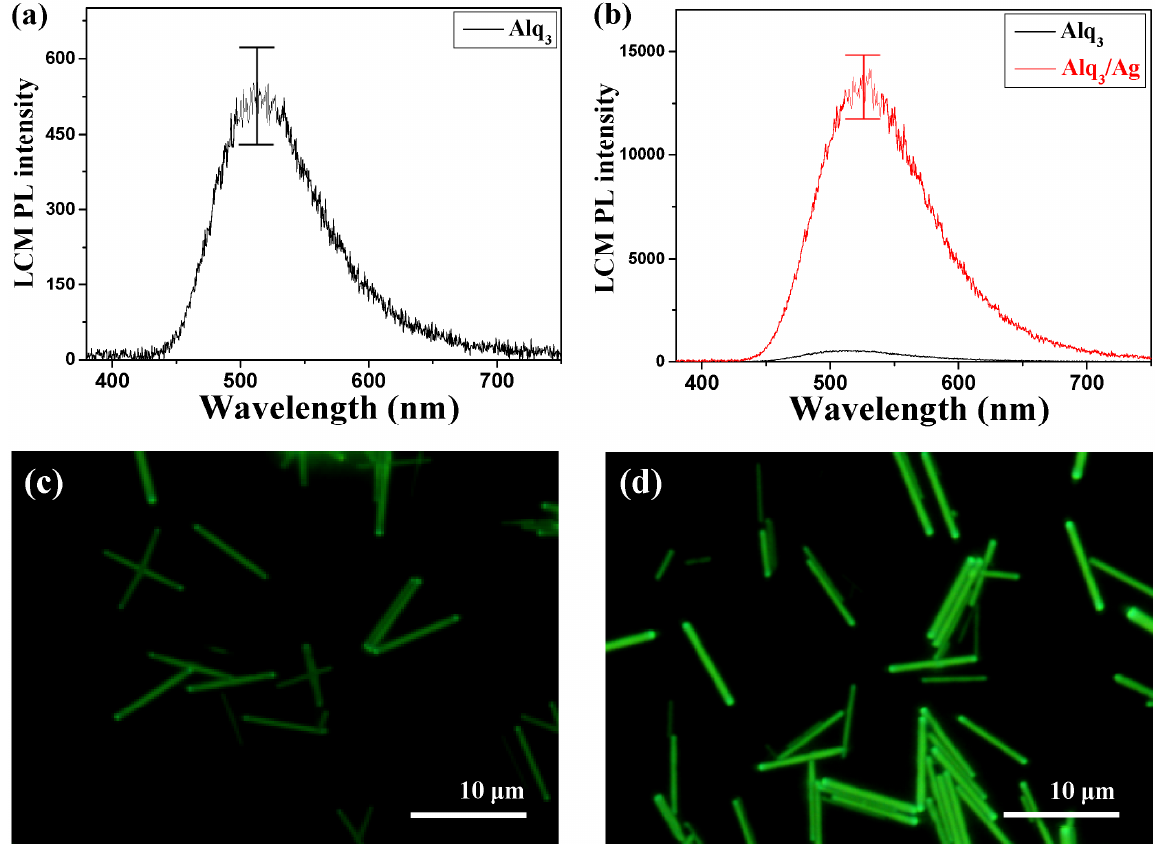
Figure 4. ( a ) PL spectrum of the pristine Alq 3 MRs. ( b ) Comparison of PL spectra of the pristine Alq 3 MRs and hybrid Alq 3 /Ag NWs-MRs. ( c , d ) show the corresponding color CCD images of the pristine Alq 3 MRs ( a ) and hybrid Alq 3 /Ag NWs-MRs ( b ), respectively. Table 1. Comparison of the structural characteristics and typical PL features in the various hybrid organic/metal structures.